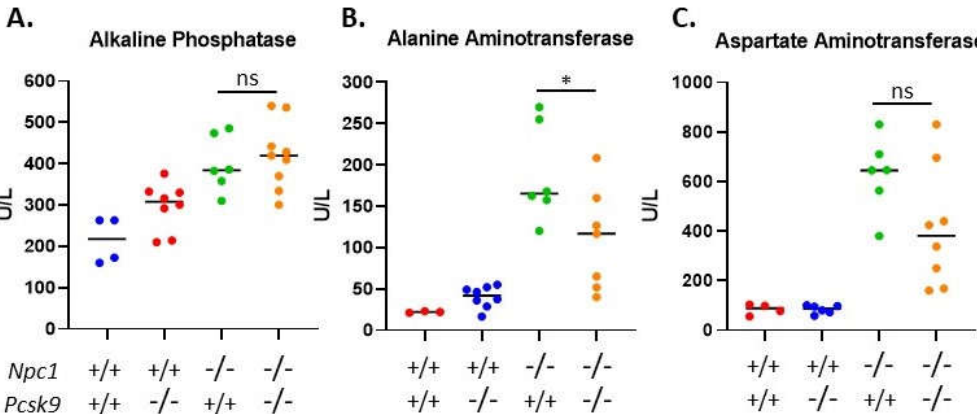
Figure 5. Serum liver enzyme levels in Pcsk9 - / - mice in the context of Niemann–Pick disease, type C1 (NPC1) disease. In order to assess liver function, serum was collected from control and mutant mice at 7–8 weeks of age. All three enzymes, ( A ) alkaline phosphatase (AP), ( B ) alanine aminotransferase (ALT) and ( C ) aspartate aminotransferase (AST), were elevated in the Npc1 - / - mice compared to control mice. The levels of AP and AST between Pcsk9 - / - / Npc1 - / - and Pcsk9 +/+ / Npc1 - / - were not statistically di ff erent, whereas the ALT was slightly reduced in the Pcsk9 - / - / Npc1 - / - mice. These results demonstrate that liver function was a ff ected similarly in Npc1 - / - mice in the presence or absence of PCSK9.